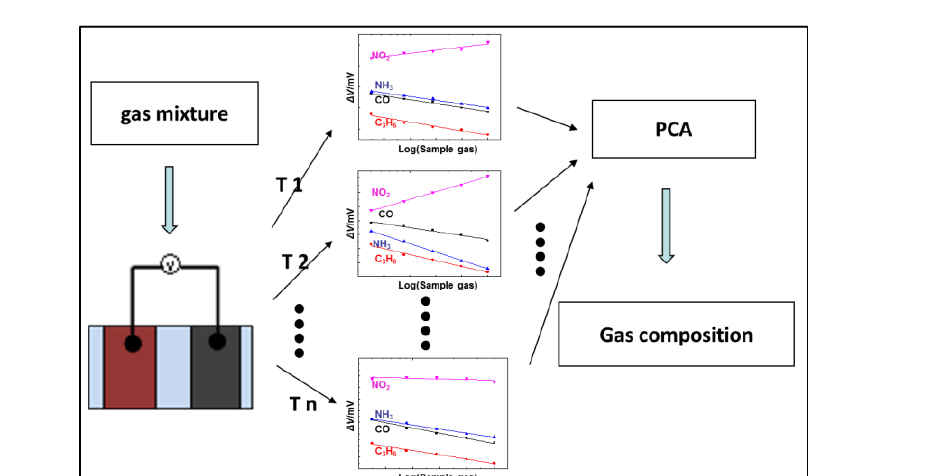
Figure 6. Flowchart of processing the response pattern that was obtained from the temperature modulation mode with PCA software in detail.